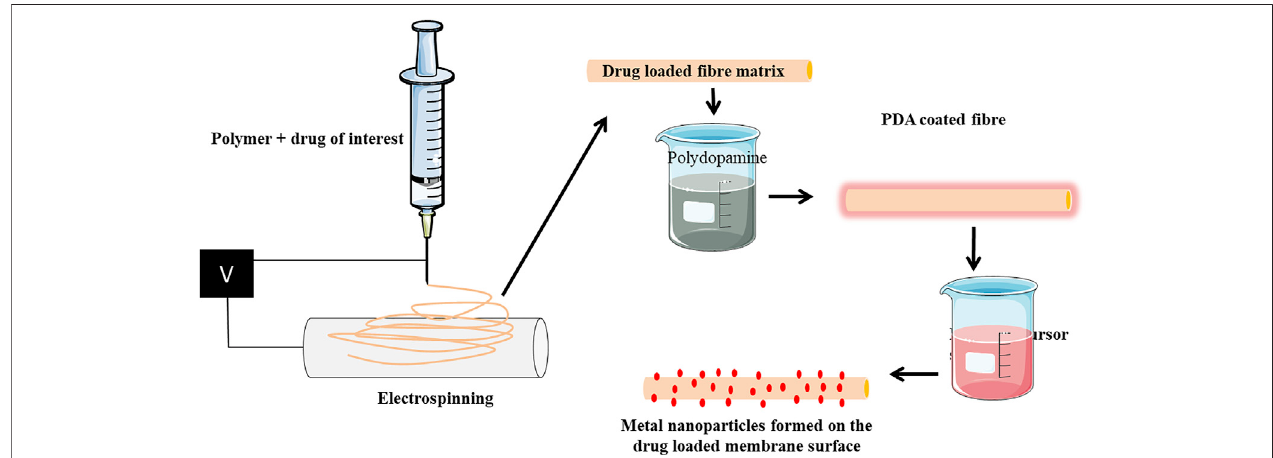
FIGURE 1 | Scheme representing the expansion of the ideology provided by Jialong et al. (2020). Drug can be incorporated into the PLLA fi ber by mixing polymer and drug solution prior to electrospinning. The electron spun matrix can be coated with PDA followed by immersion into respective metal precursor solution. The membranewill havedrug loadedintothem and metallic nanoparticles willbeformed onthesurface. Suchmatrix canbeused forvarious tissue engineeringpurposes for carrying drugs along with metallic nanoparticles.